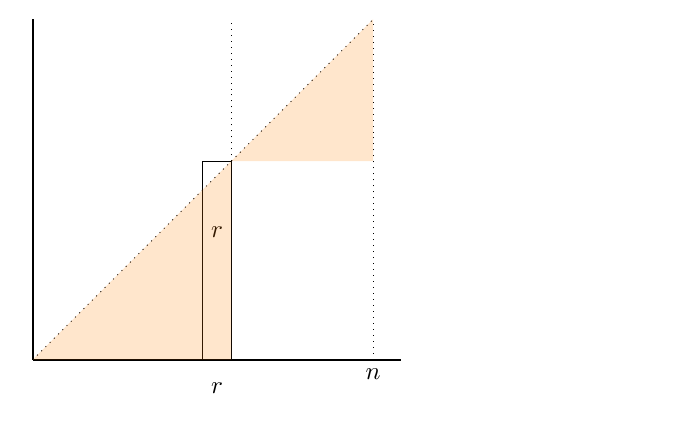
Figure 2: Sketch indicating an alphabetic point s in position r = s in an inversion